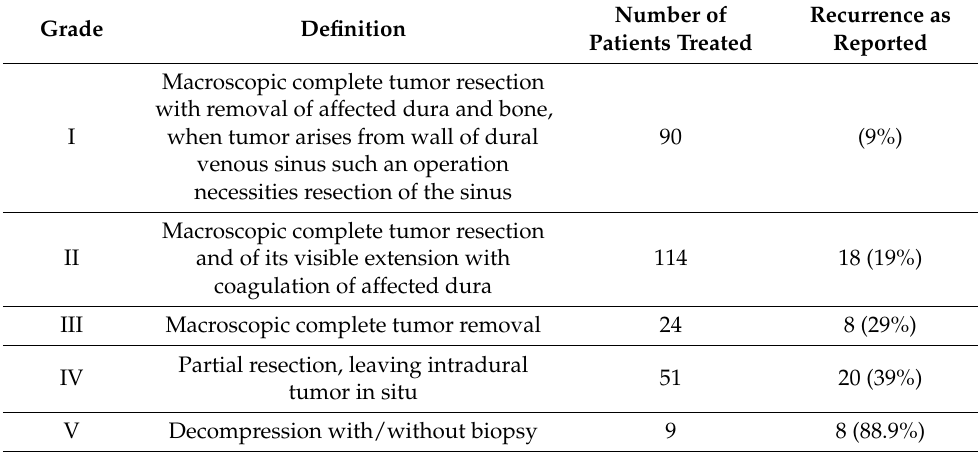
Table 1. The Simpson